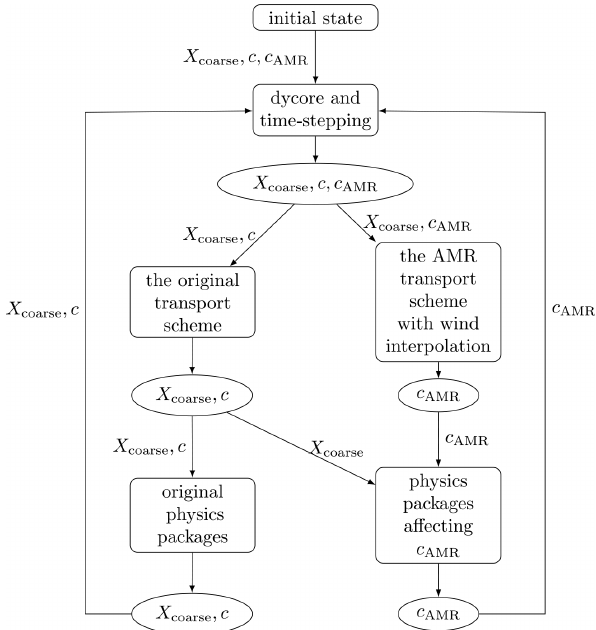
Figure 21. Illustration of our setting for the one-way coupling experiment. c is the tracer mixing ratio on the coarse resolution, X coarse is a vector of variables other than the tracer mixing ratio in the model at a coarse resolution, and c AMR is the tracer mixing ratio of the AMR scheme. The rectangles include modules and processes in the model, ellipses are the output of each module or process, and arrows indicate the input variables in each module or